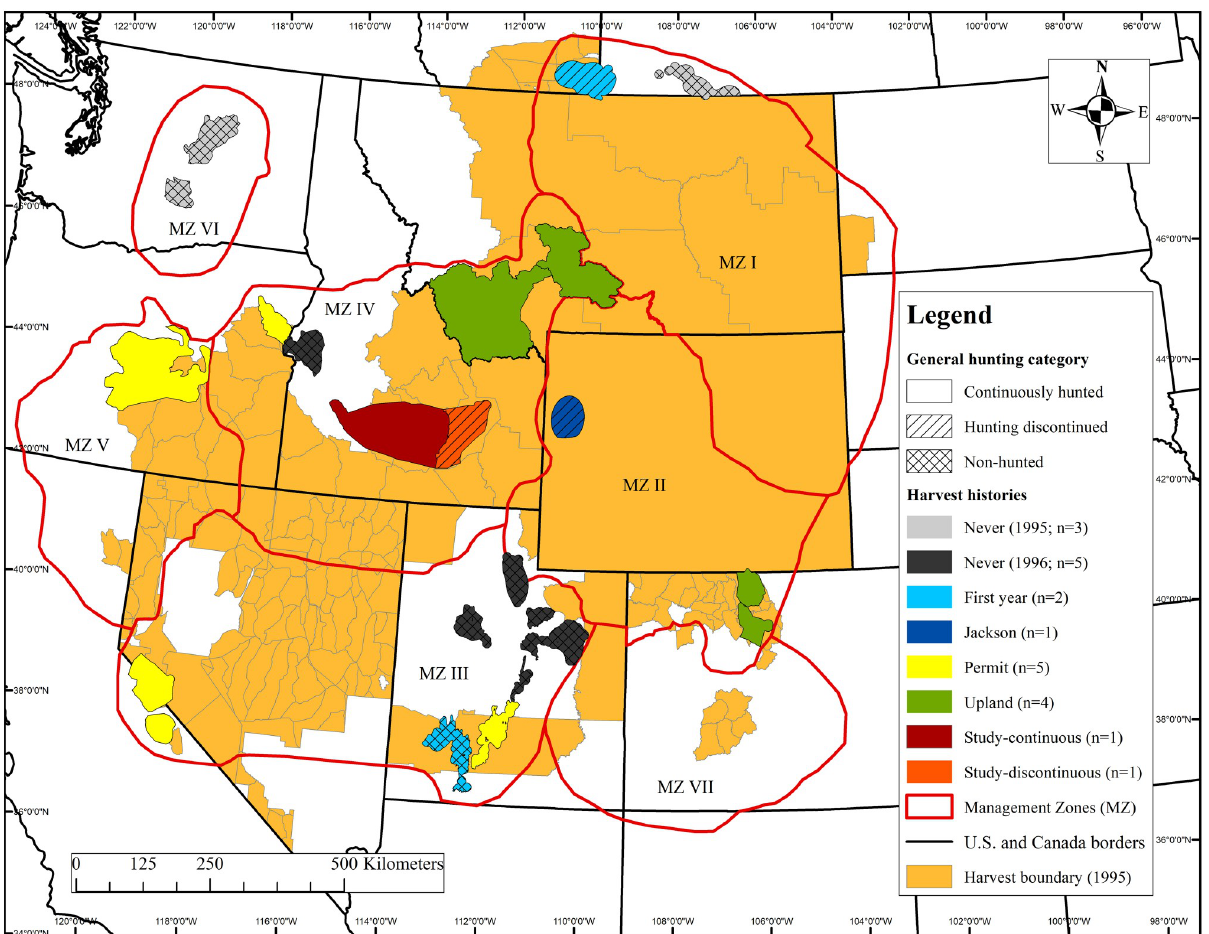
Fig 1. Map of 21 relatively distinct sage-grouse populations stratified into 8 regulation histories. Orange background portrays legal hunting season boundaries in 1995. Light green delineates the presumed distribution of sage-grouse, and multi-colored polygons indicate 8 km buffers around active sage-grouse leks within these populations as of 1995. Lek data were collected by states and provinces throughout the western United States and southern Alberta and Saskatchewan Canada from 1995–2013.